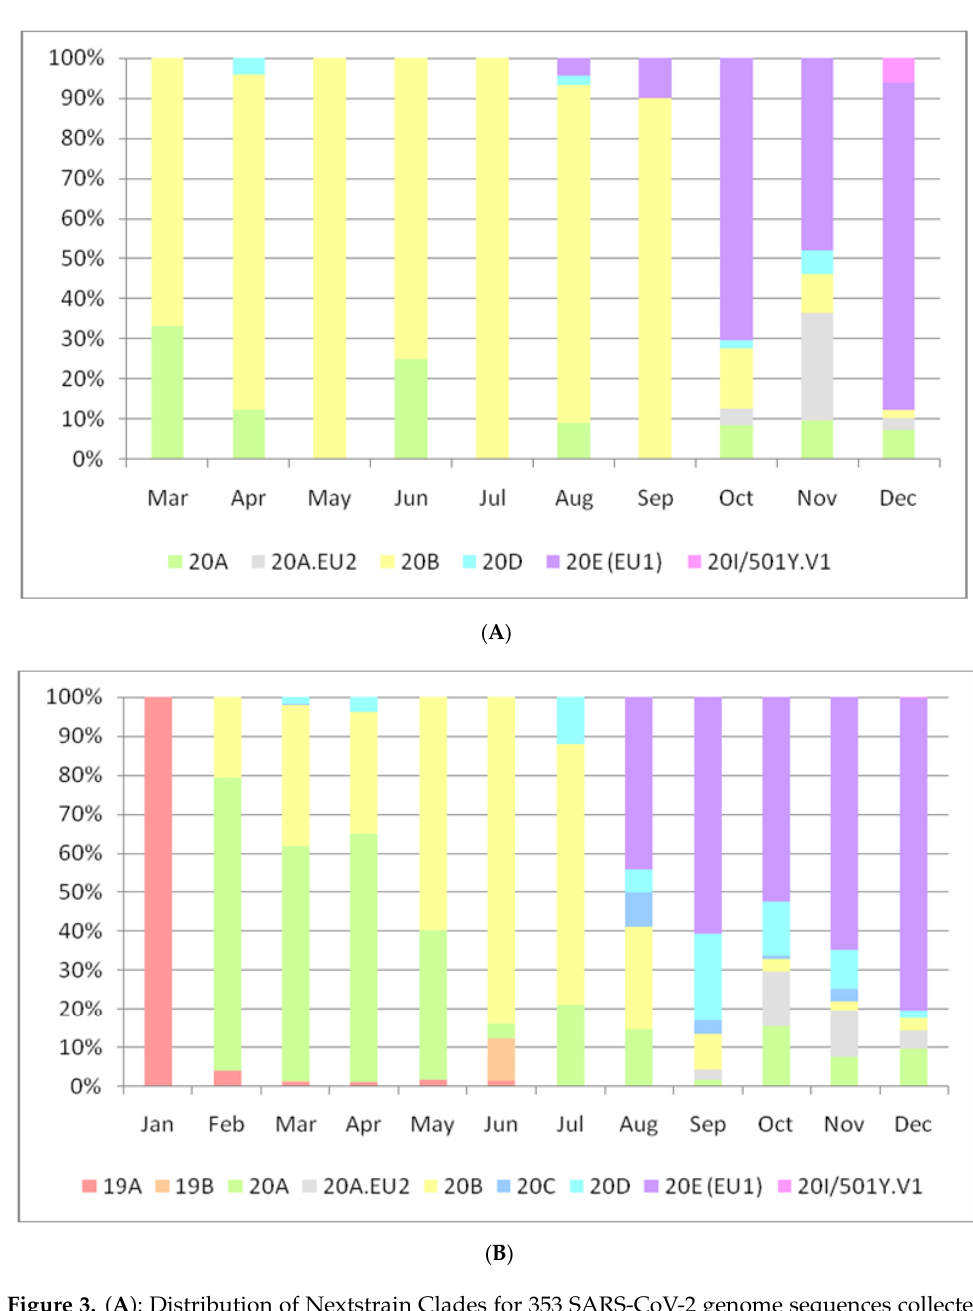
Figure 3. ( A ): Distribution of Nextstrain Clades for 353 SARS-CoV-2 genome sequences collected from the Apulia and